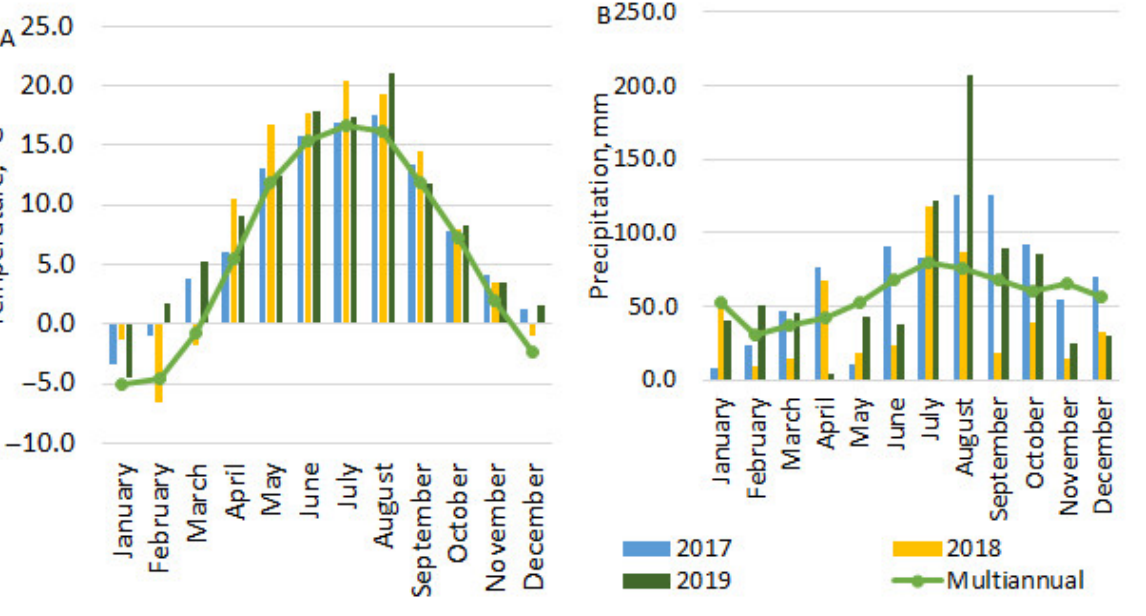
Figure 1. Meteorological conditions (( A ), temperature, °C; ( B ), precipitation, mm) during three vegetation periods (2017, 2018, and 2019).